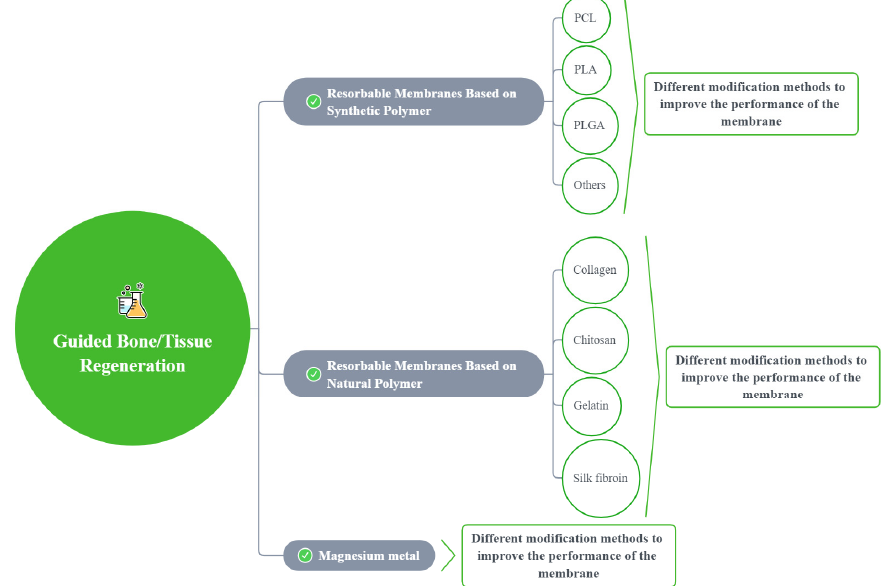
Figure 3. A sketch showing the modification methods for different membranes.